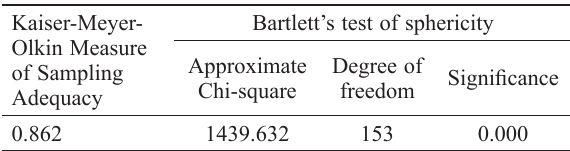
Table 2. KMO and Bartlett’s test for critical organizational